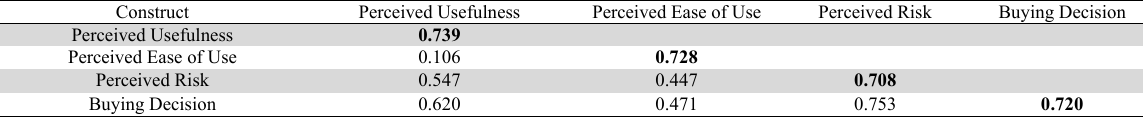
Results of Discriminant Validity using Fornell and Larcker Criterion